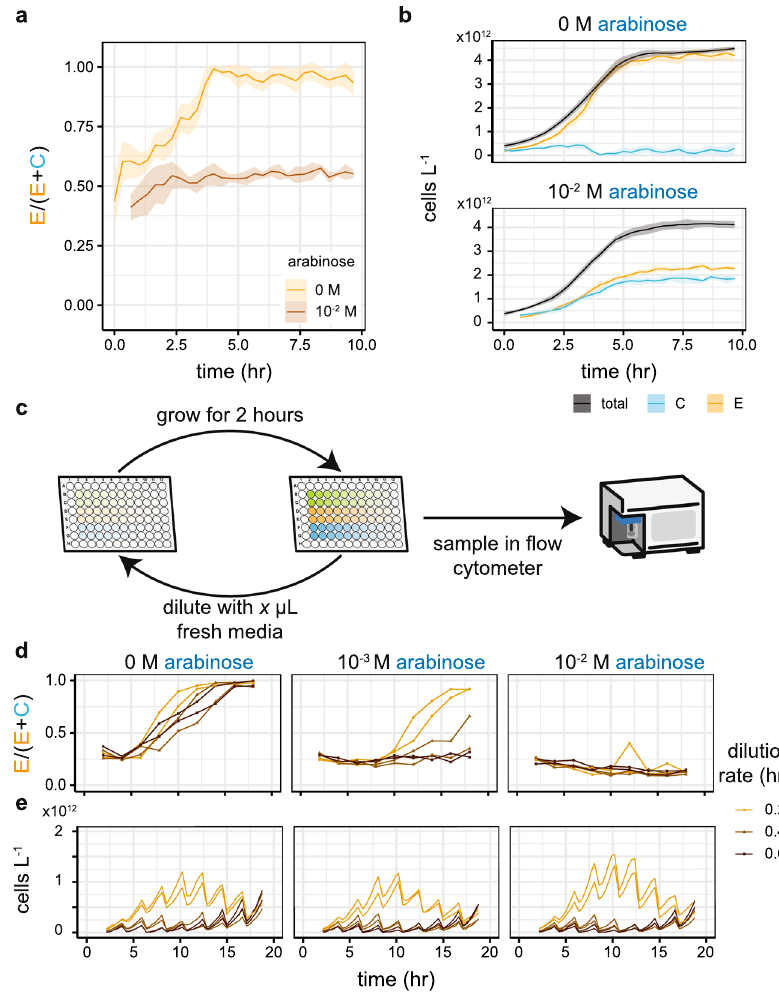
Fig. 8 Demonstration of community stabilisation. a Co-cultures of engineered and competitor strains grown in microtitre plates. Without arabinose in the media, no 3OC6-HSL is produced and the bacteriocin is not switched off, resulting in the competitor going extinct. With 10 mM arabinose, we observe stable co-existence. b Growth curves and inferred subpopulations from a . The cultures reach saturation after ~5 h. c Co-cultures in microtitre plates were repeatedly grown and diluted with samples taken for analysis by fl ow cytometry. A range of dilution volumes was used to approximate chemostat dilution rates. d Population ratios were attained by clustering on the fl ow cytometry data. Without arabinose, the competitor strain goes extinct, though this occurs faster at the lowest dilution rate. At 10 mM arabinose, we observe co-existence at all dilution rates, for the period of the experiment. At 1 mM arabinose, the competitor is close to extinction at the lowest dilution rate and appears to be outcompeted at the intermediate dilution rate. e Growth curves demonstrate the dilution dynamics and show that saturation is not reached under any of the conditions. For a and b , lines show the mean of the rolling mean (centred window size = 3) and shaded ribbons the standard deviation of four replicates. In d , each line shows an independent competition experiment ( n = 2 for each condition). Points on the lines show fl ow cytometry samples. In e , the lines show the rolling mean (centred window size = 3) of each independent